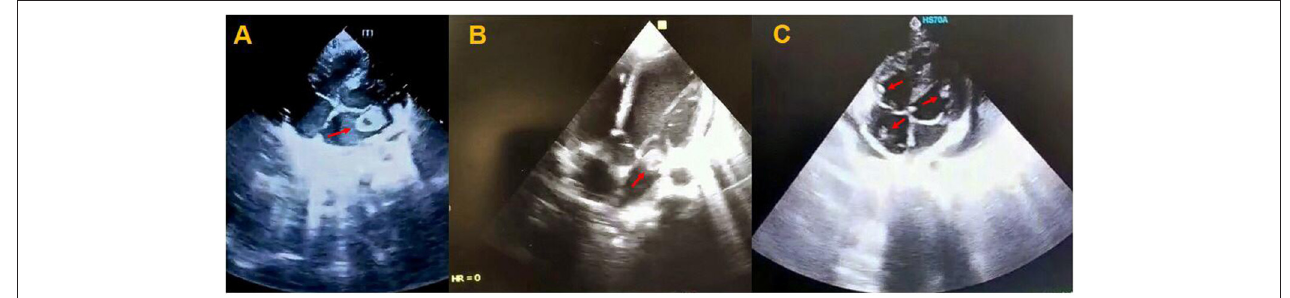
FIGURE 1 | Transthoracic echocardiogram of patients showing a mobile mass in the left atrium with attachment to the posterior leaflet of the mitral valve (A) , a large mobile mass in the left atrium (B) , and multiple mobile homogenous masses in the right side of the heart and left ventricle (C) .